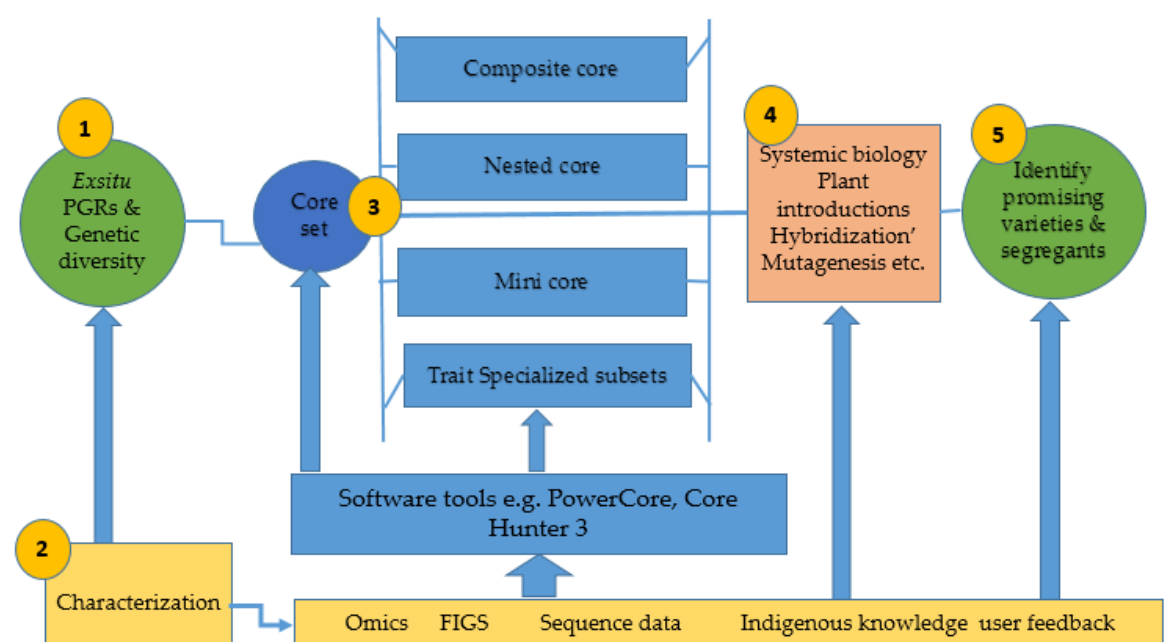
Figure 2. 1: Bambara plant genetic resources; 2: characterization approaches to establish genetic diversity and software tools to develop core sets; 3: strategies for mining PGRs; 4: deployment of core sets in various applications; and 5: target end products for the variety improvement process. Source: